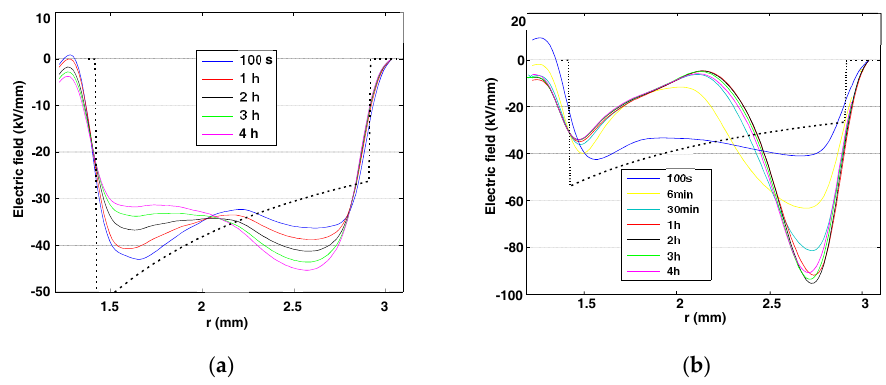
Figure 2. Field distribution obtained in the insulation of miniature cable samples with 1.5 mm thick insulation. Measurements were achieved under a thermal gradient of 10 °C, (T in = 70 °C; T out = 60 °C), under a voltage of − 55 kV applied to the conductor. ( a ) degassed sample; ( b ) partly degassed sample. The dashed curve is the geometric field distribution.